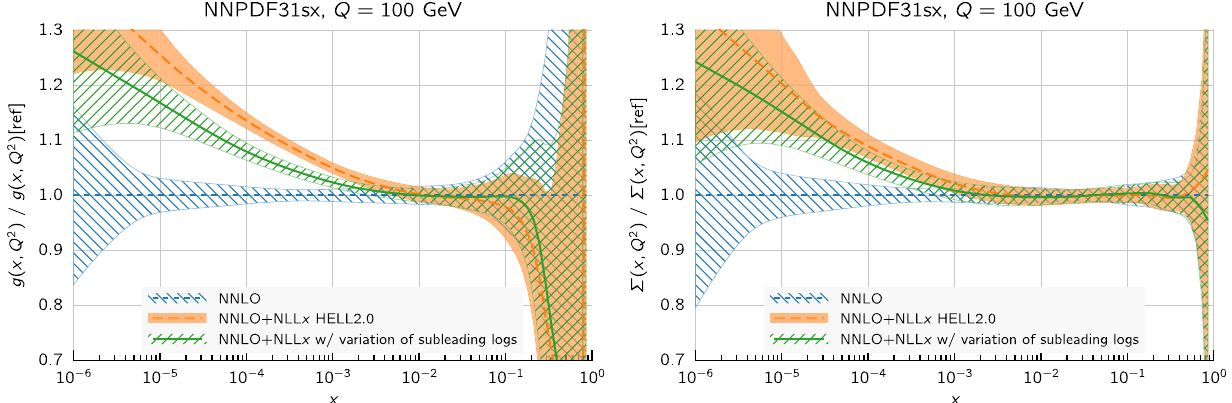
Fig. 11 Comparison between the gluon (left) and the total quark singlet (right plots) from the NNLO and NNLO+NLL x DIS-only fits, including the variant of the resummation which differs by subleading terms, as discussed in the